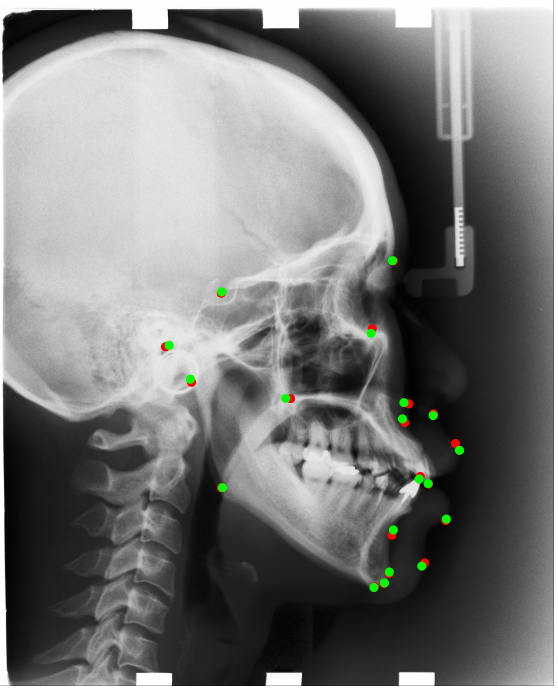
Figure 8. Green points: predicted landmarks’ locations. Red points: ground-truth of landmarks’